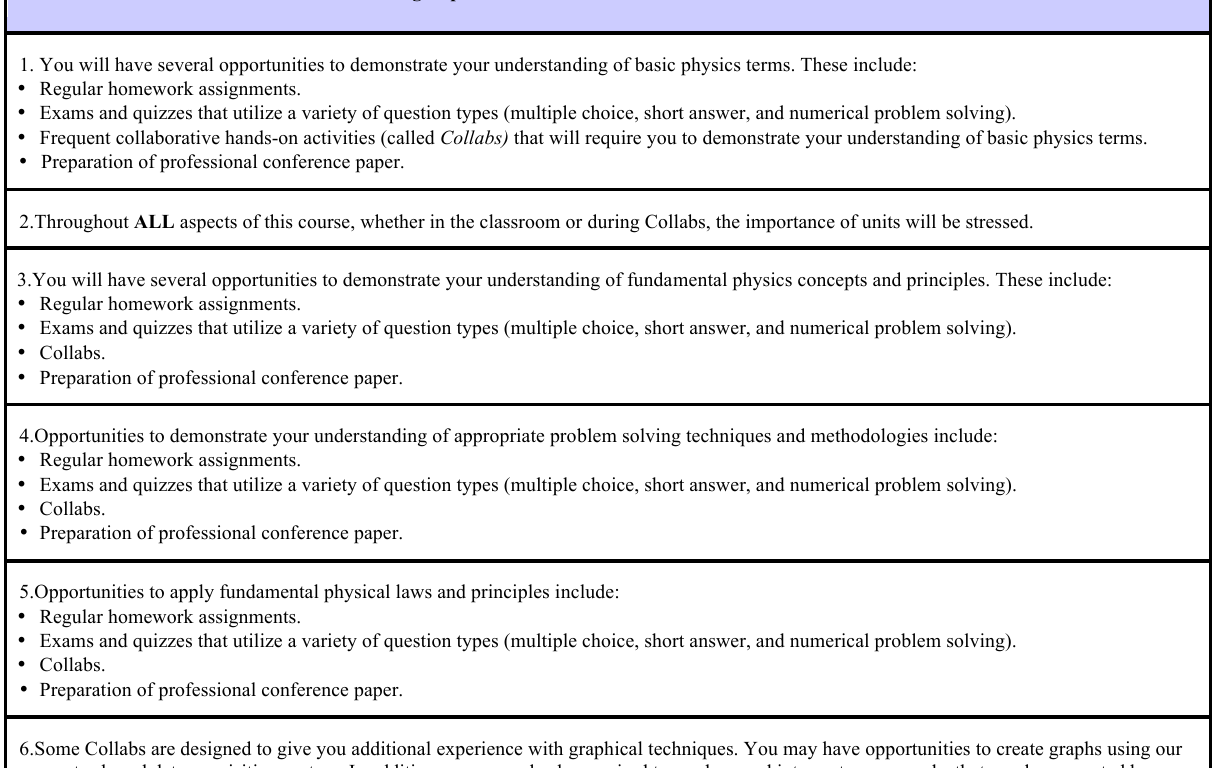
TABLE III. A SSESSMENT M